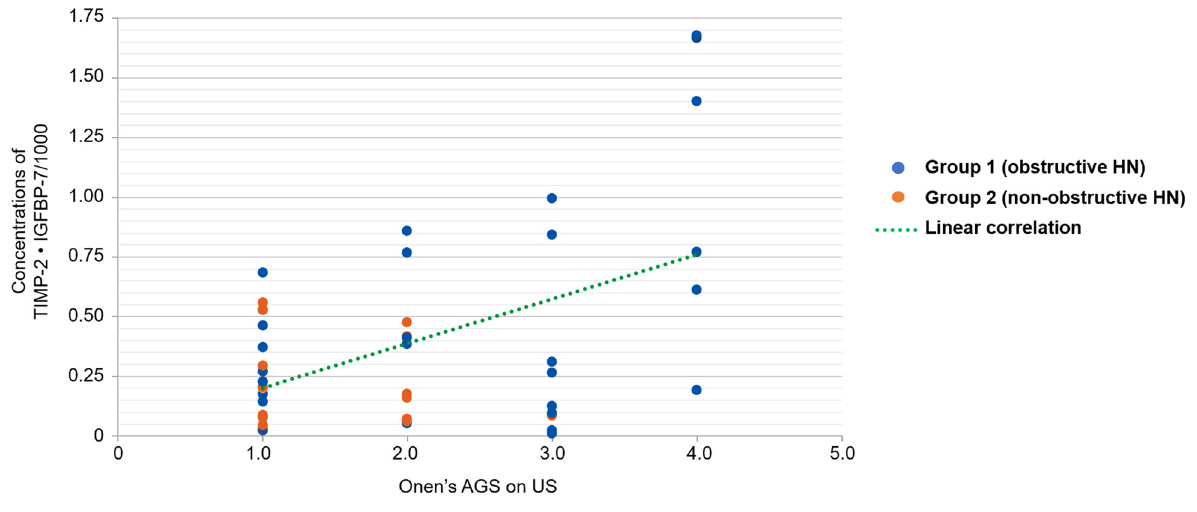
Figure 3 - The figure shows the correlation between first samples concentrations, before any treatment, of TIMP-2.